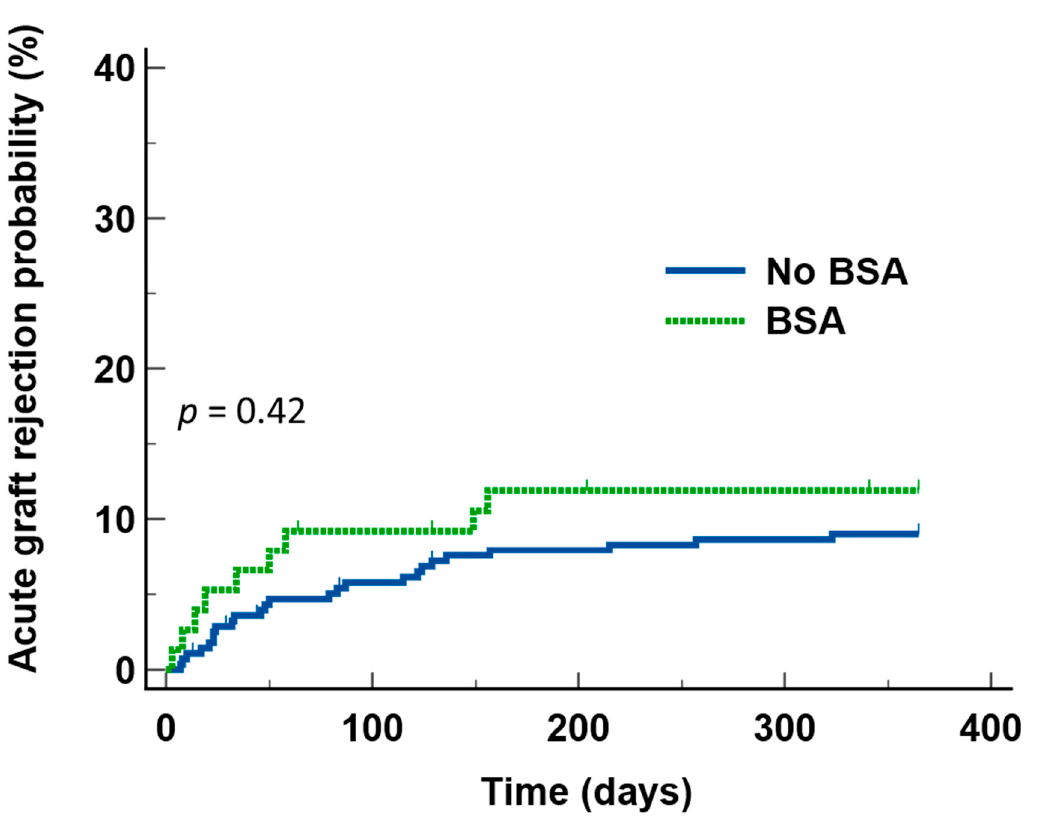
Figure 2. Acute graft rejection during the first year after transplant in patients who received broad- spectrum antibiotics (BSA) and those who did not, showing that there was not any statistical difference between the two groups.